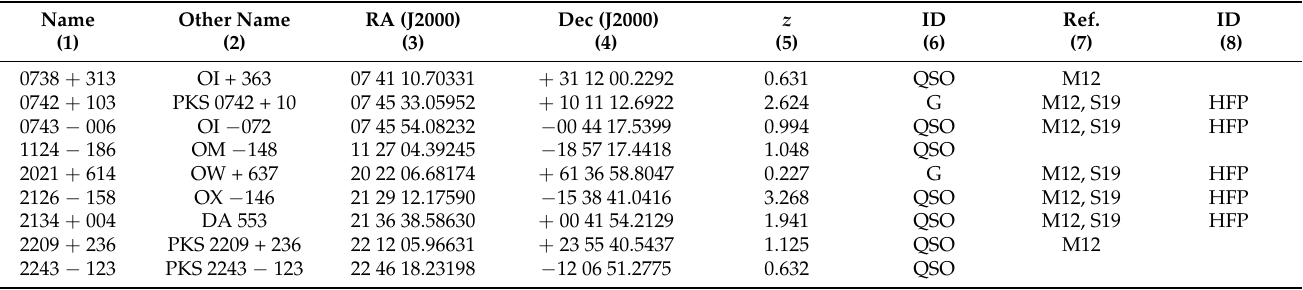
Table 1. High frequency GPS sample.